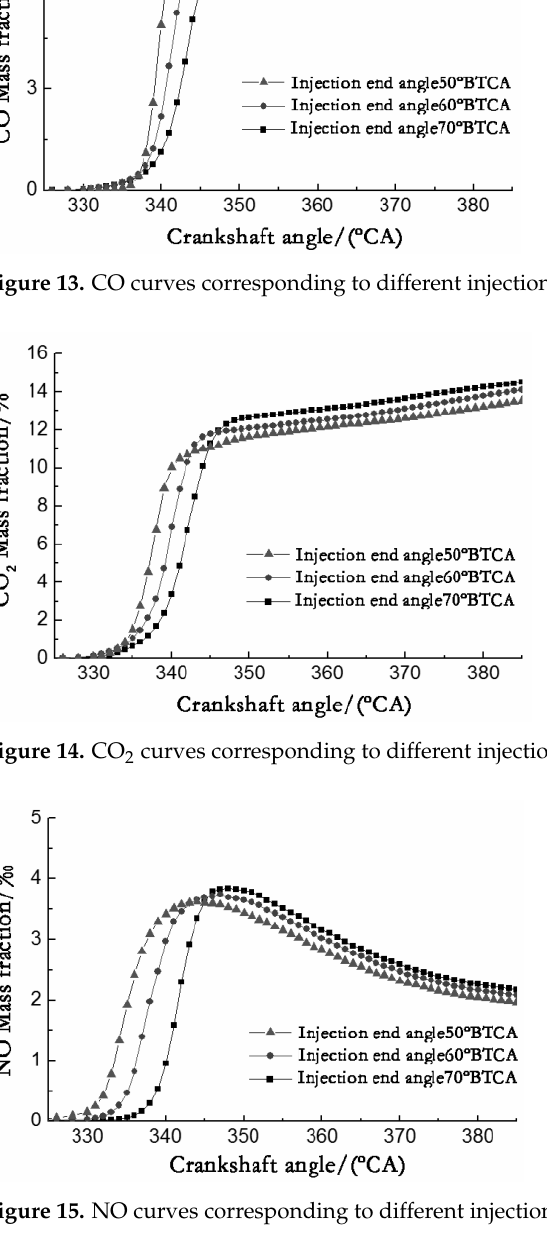
Figure 16. Soot curves corresponding to different injection end angles. Figures 17–20 show the concentration data of each emission component when the exhaust port was opened. When the injection end angle changed from 50° to 70° BTDC, CO and soot gradually decreased, and CO 2 and NO gradually increased. Figure 17. CO data corresponding to different injection end angles.